Question: Write the caption for this figure.
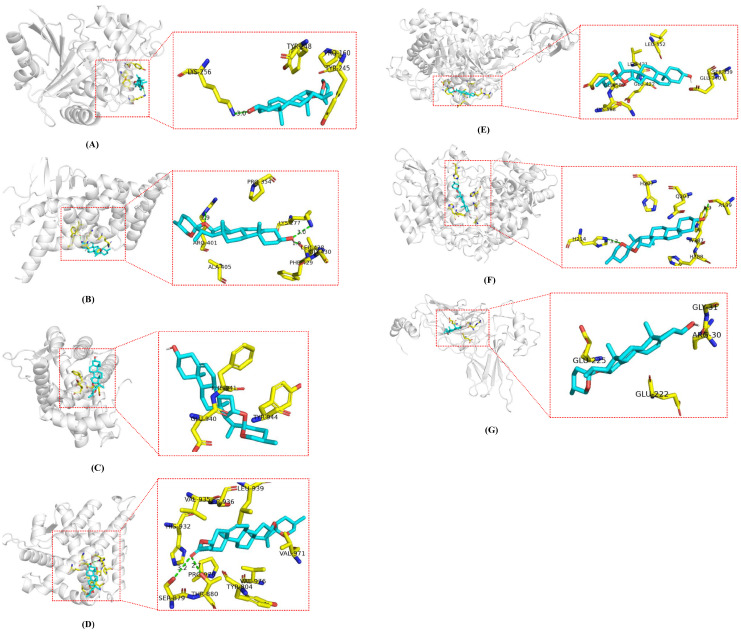
Answer: Molecular docking results (Bixie). (A) Molecular docking of CAT with diosgenim. (B) Molecular docking of NR1I2 with diosgenim. (C) Docking plot of NR3C2 with diosgenim. (D) Docking of NR3c2 with EINECS_213-897-0. (E) Docking of PLA2G4A with diosgenim. (F) Docking of PTGS2 with diosgenim. (G) Docking of RELA with diosgenim.